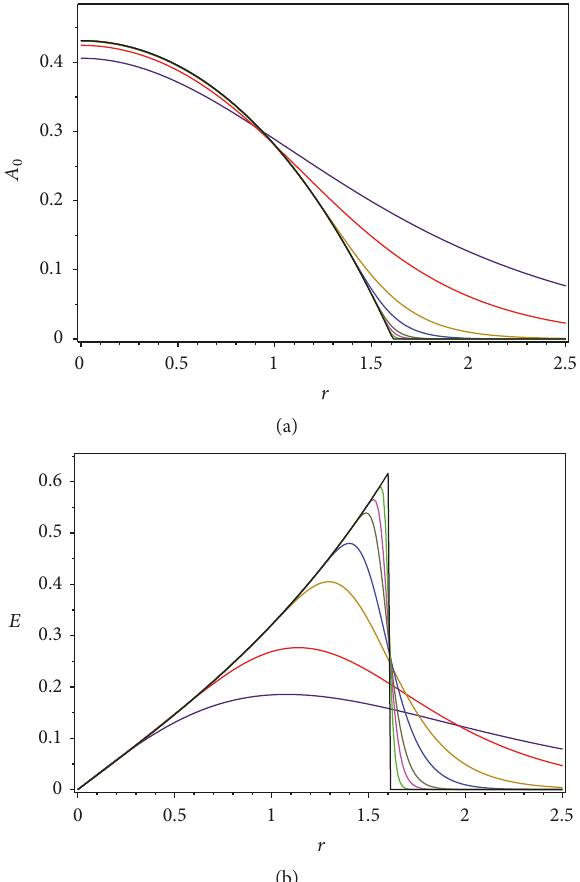
Figure 8: The scalar potential 𝐴 0 (𝑟) (a) and the electric field 𝐸(𝑟) (b) come from generalized Maxwell-Chern-Simons-Higgs model (93) with 𝐺(𝑔) = 1 and 𝜔(𝑔) = 𝜆𝑔 2𝜆−2 . Observe that 𝜆 = 1 (indigo lines) represents the usual MCSH model and the true compacton solution is given by 𝜆 = ∞ (black lines). The convention for the color of the lines is the same given in Figure